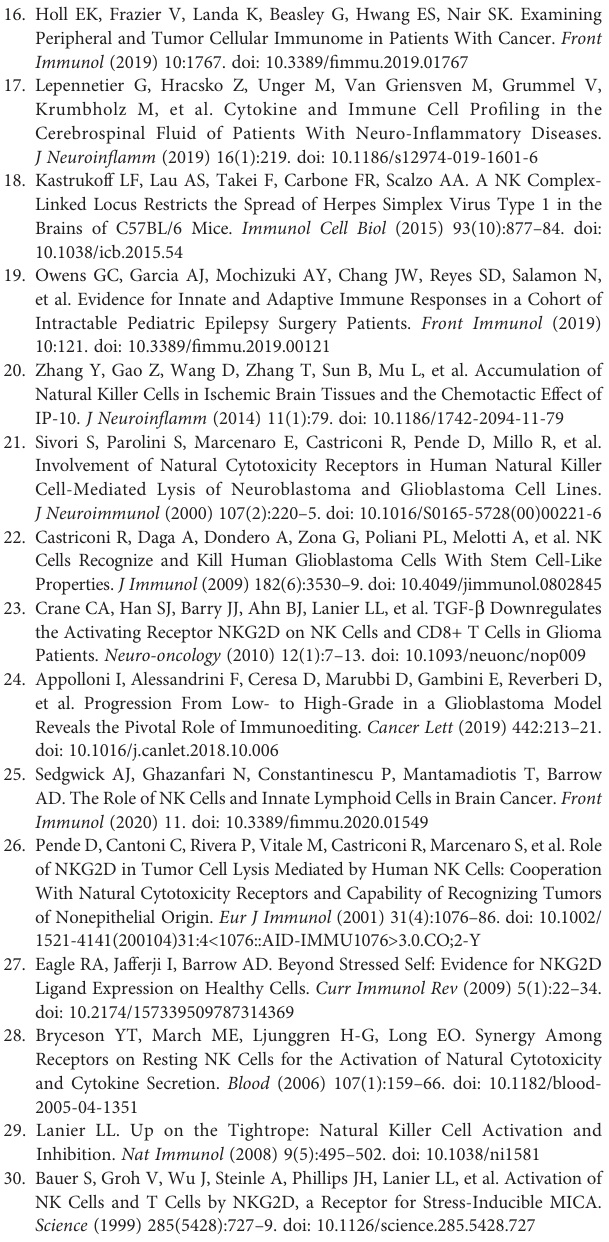
Supplementary Figure 3 | Pro fi les of NK and T cell subset phenotypes in LGG patients. (A) Pro fi les showing original fractions of NK and T cell phenotypes in LGG tumors (B) Proportions of total NK and T cell abundance in LGG tumors.